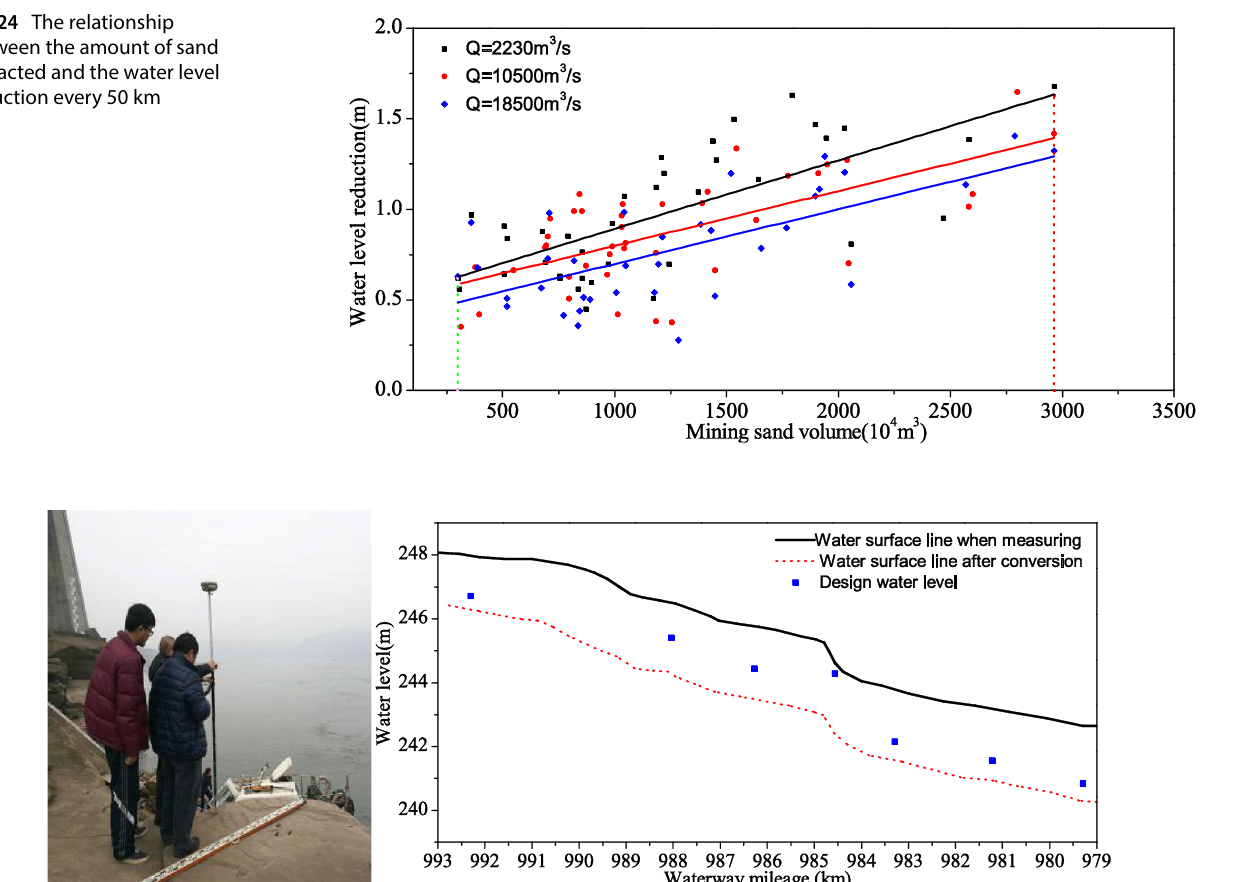
Fig. 25 Water gauge check and water level